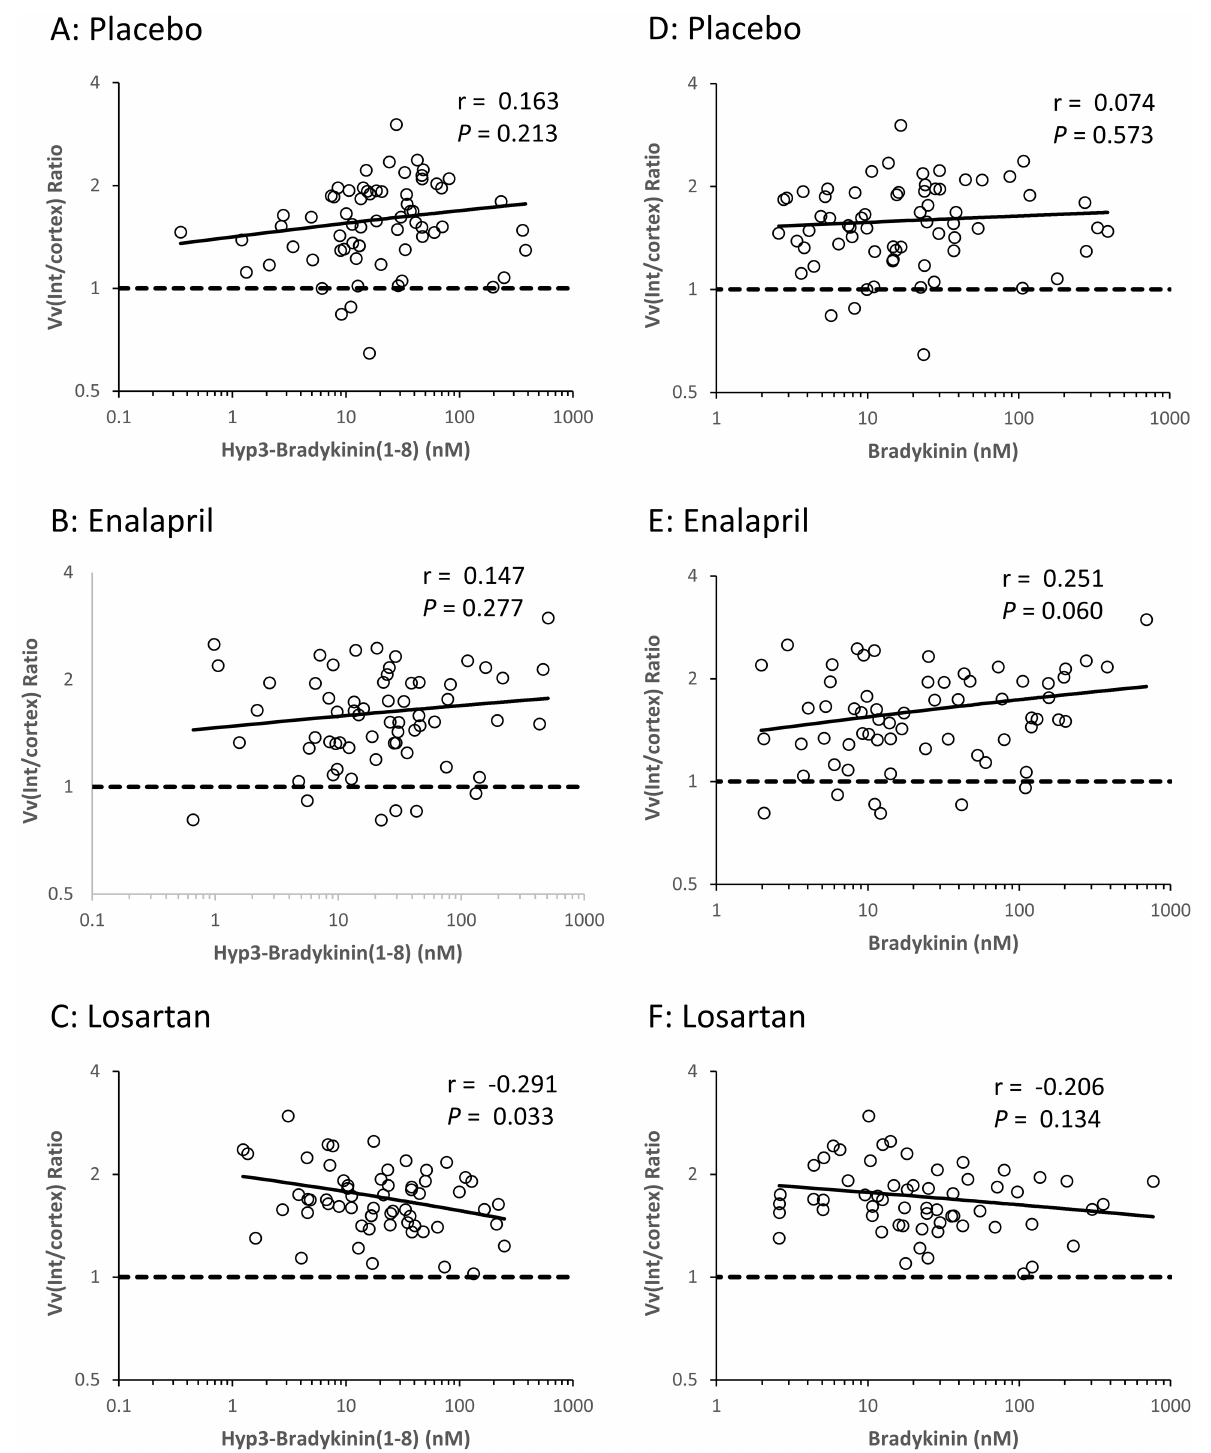
Fig 3. Associations of baseline BK and hyp3-BK(1–8) with change in cortical interstitial fractional volume [Vv(Int/cortex)] in the 66 participants assigned to placebo, the 63 participants assigned to enalapril, and the 60 participants assigned to losartan in RASS. Residualswere computedby regressing each of the variableson baselineage, durationof diabetes,HbA1c, mean arterial pressure, treatment assignment and baselineVv(Int/cortex). Residualsare plotted on logarithmic scales. Valuesabove the dashedlines reflect an increasein Vv(Int/cortex) and those below the lines a decreaseover 5